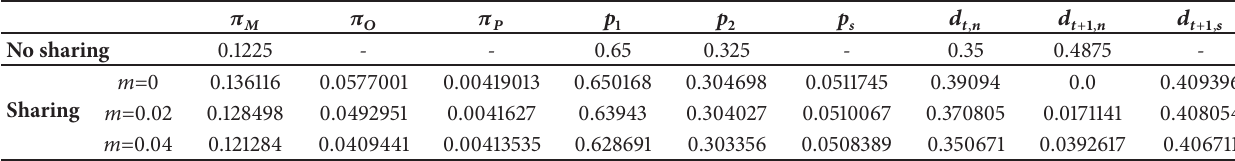
Table 2: Examples with a low-cost product.